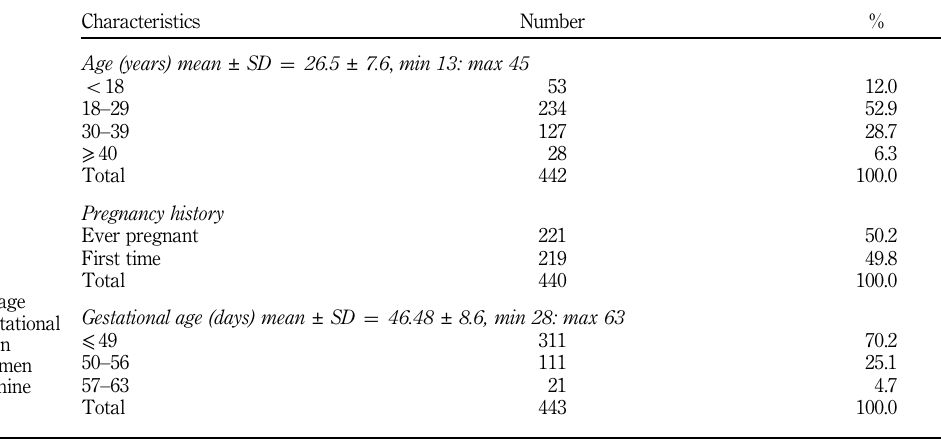
percentage of age group and gestational age distribution among the women enrolled from nine study